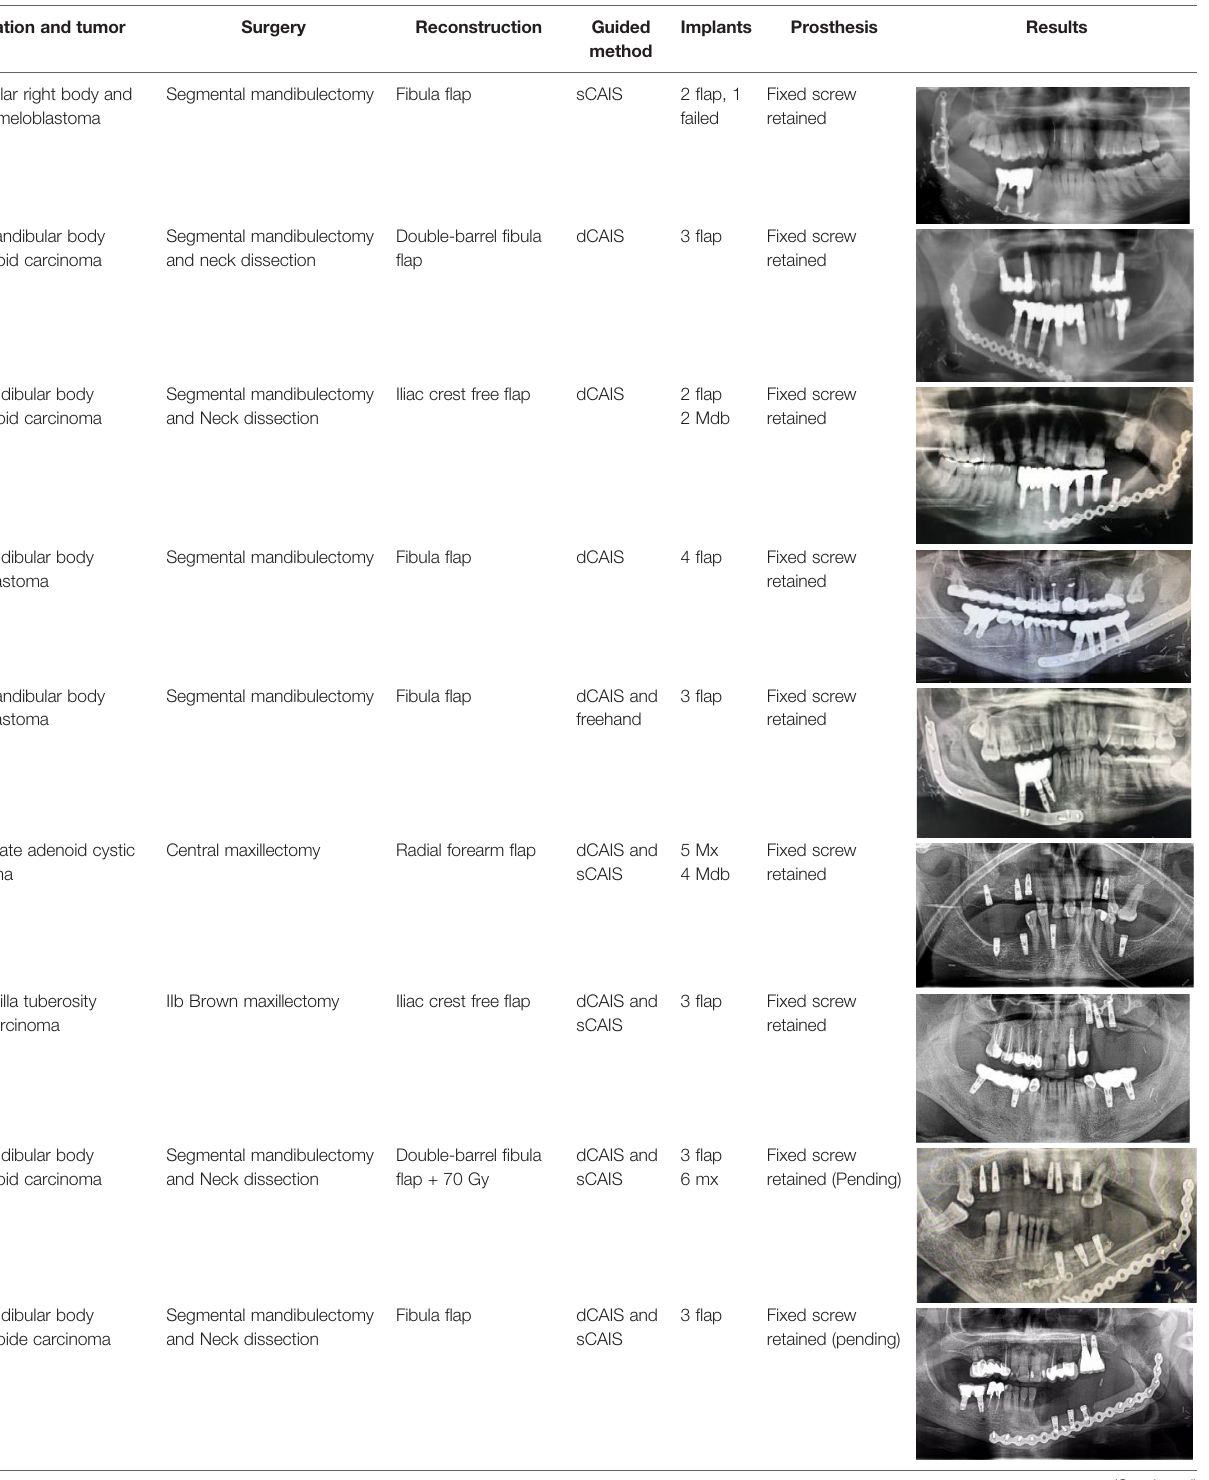
TABLE 1 | Characteristics of the patients participating in this